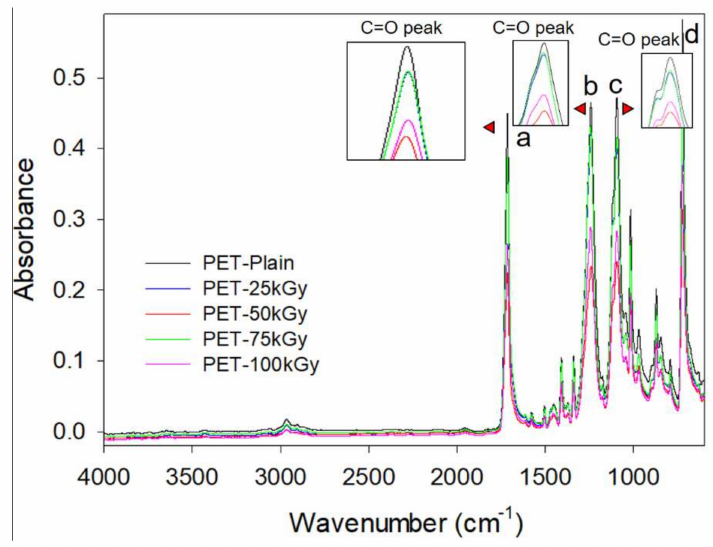
Figure 18. FT-IR spectra of polyethylene terephthalate (PET) aggregate with different irradiation